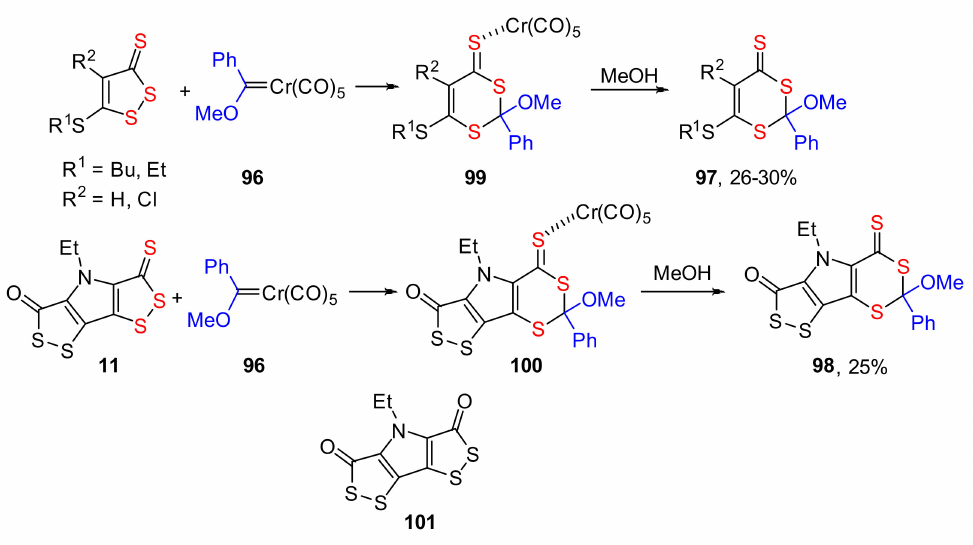
1,3-dithiine 4-thione 104 was isolated as the main product (Scheme 59).